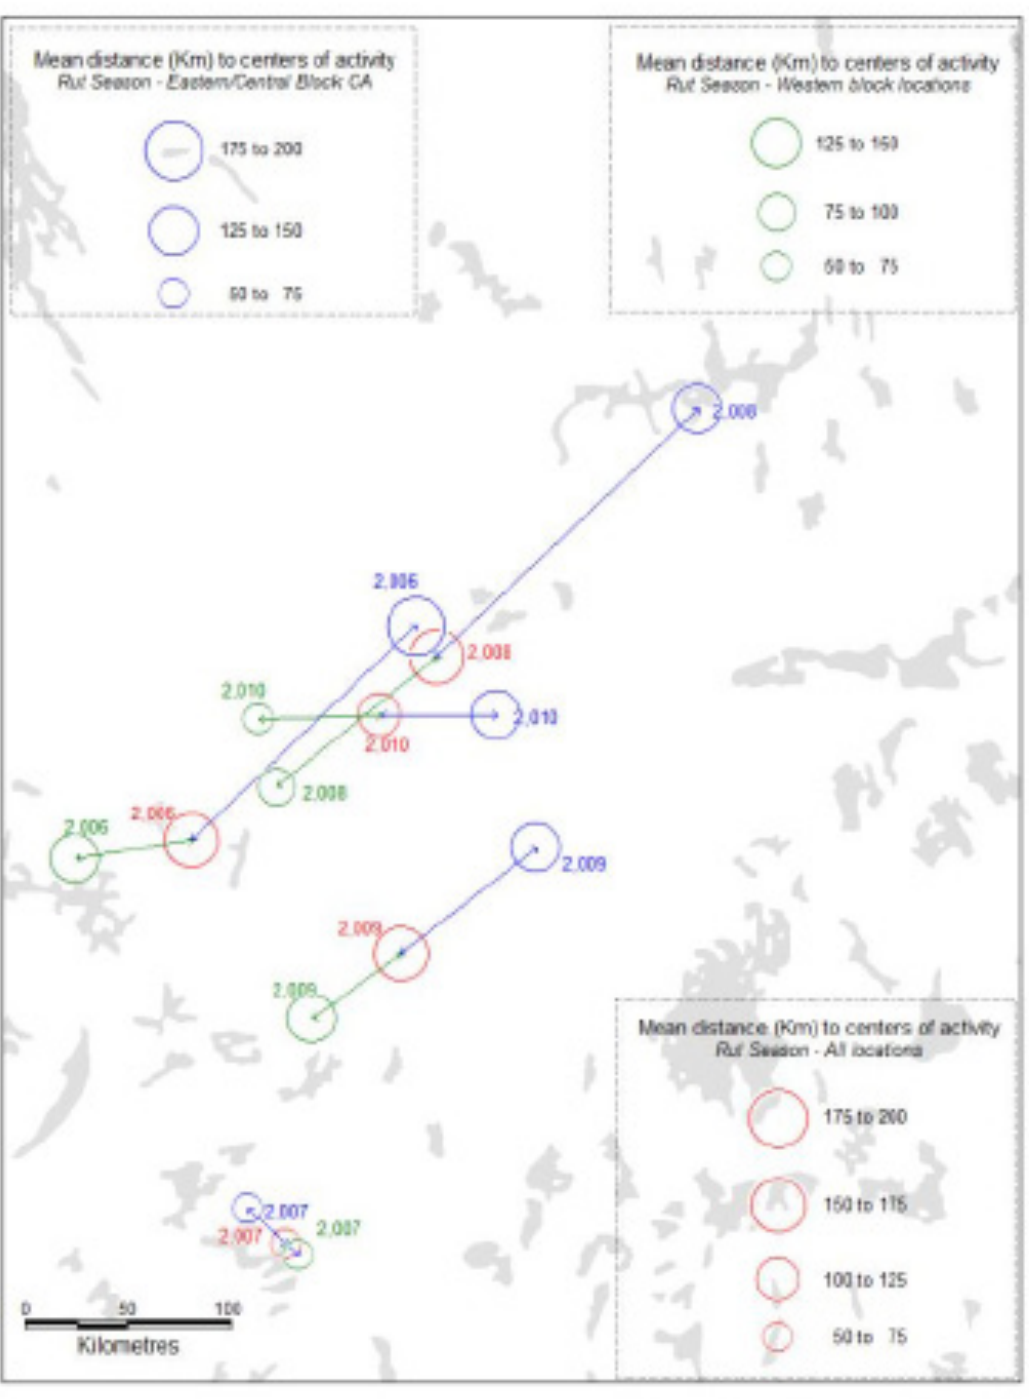
Fig. 6. Location and mean distance between centroids for rutting locations based on western, eastern/central and com- bined calving associations,